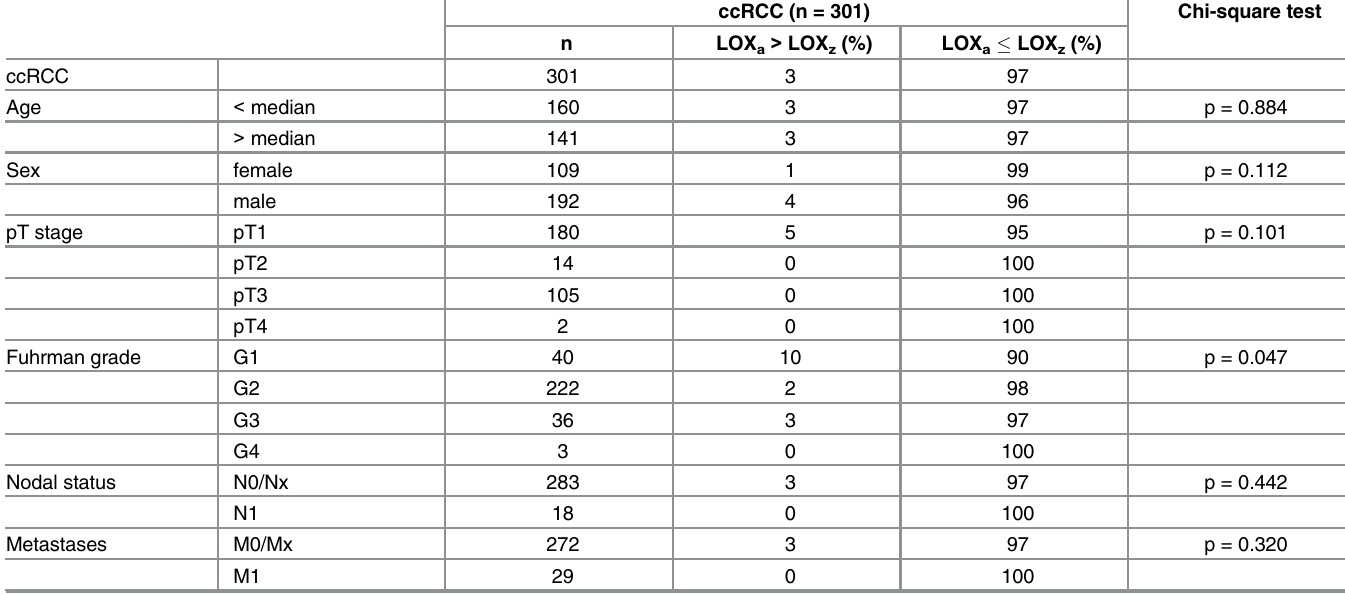
Table 4. LOX protein expression pattern in